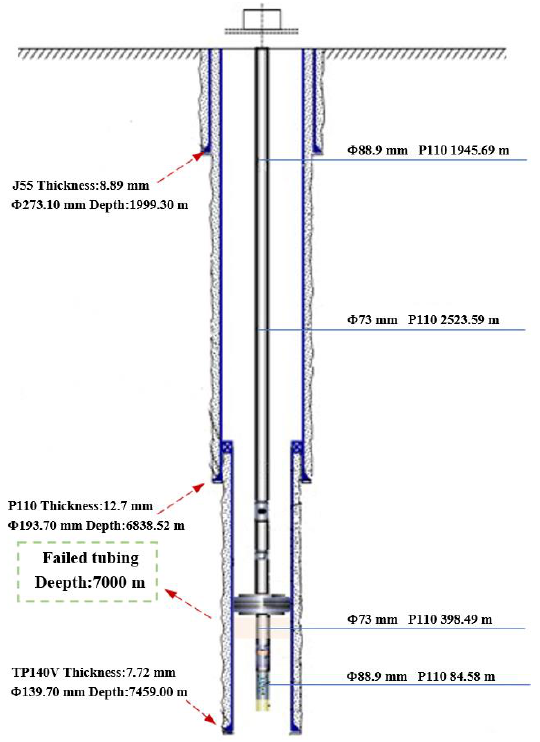
Figure 1. Failure position of tubing in the wellbore.